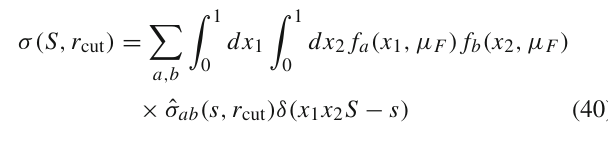
and (39), respectively. The upper panels show the result normalised to the Born cross section, while the lower panels show the result nor- malised to the r cut → 0 limit. The computation is carried out at fixed β = 0 .